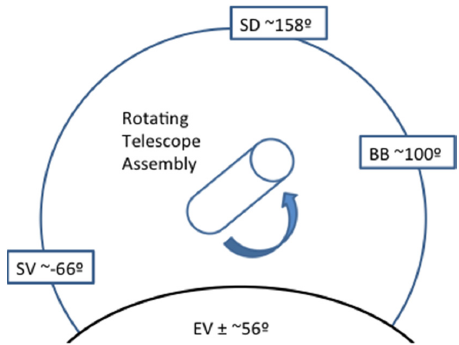
Figure 1. Schematic of VIIRS data collection windows and their approximated angles. The scan angle at the Earth’s limb is ~62.5